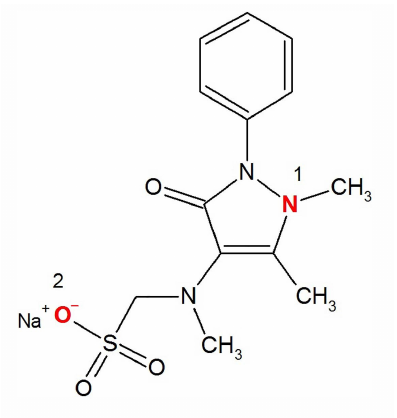
Figure 5. The structural formula of sodium metamizole.